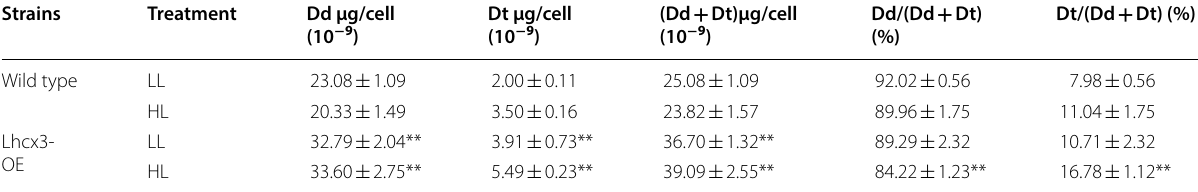
Data represent the means of three independent samples compared with HL- or LL treated WT, respectively.